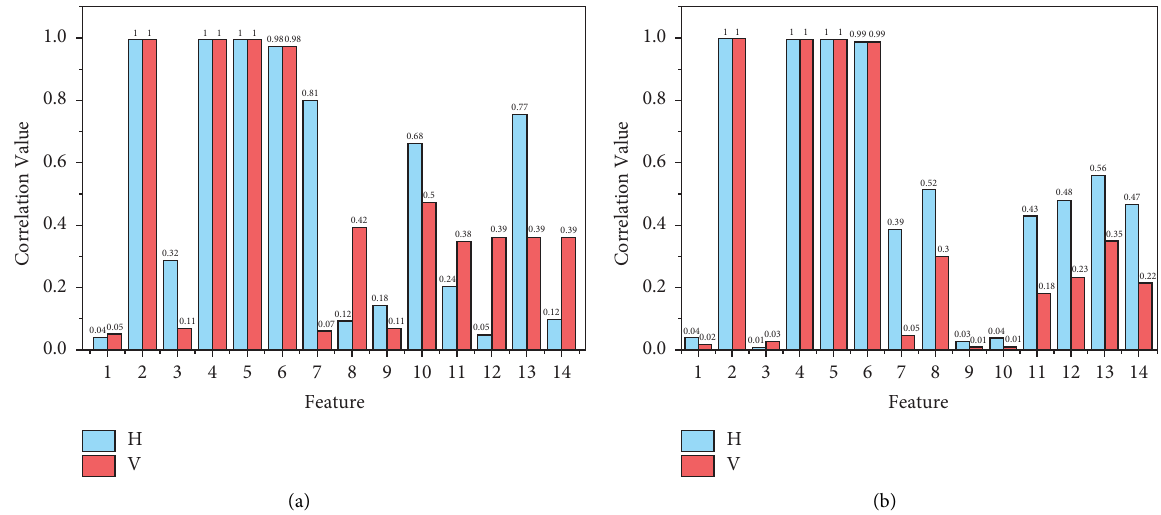
Figure 7: Time-domain feature correlation coefcient. (a) Bearing 1-2. (b) Bearing 2-1. ∗ 1: Mean. 2: Standard deviation. 3: Coefcient of variation. 4: Square root amplitude. 5: Root mean square. 6: Peak-to-peak. 7: Skewness. 8: Kurtosis. 9: Skewness factor.10: Kurtosis factor.11: Peak factor. 12: Margin factor. 13: Waveform factor. 14: Impulse index.